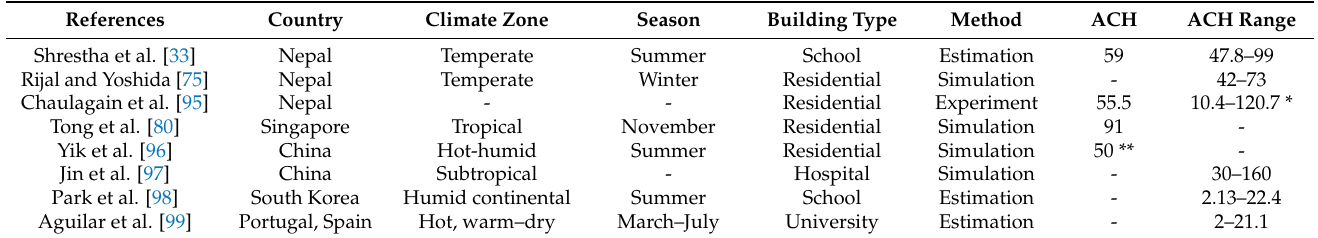
Table 7. Summary of ACH and its range in previous studies conducted in various indoor spaces.